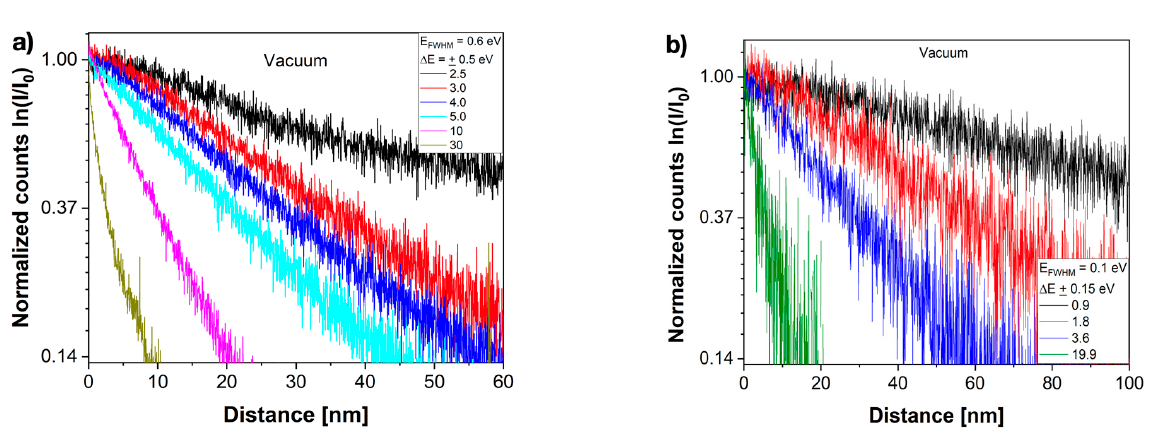
Figure 5. Selected intensity decays from the interface at x = 0 nm into the vacuum. Averaged data are normalized to 1 at the interface and plotted logarithmically. ( a ) Energy spread = 0.6 eV ( b ) Energy spread = 0.1 eV.